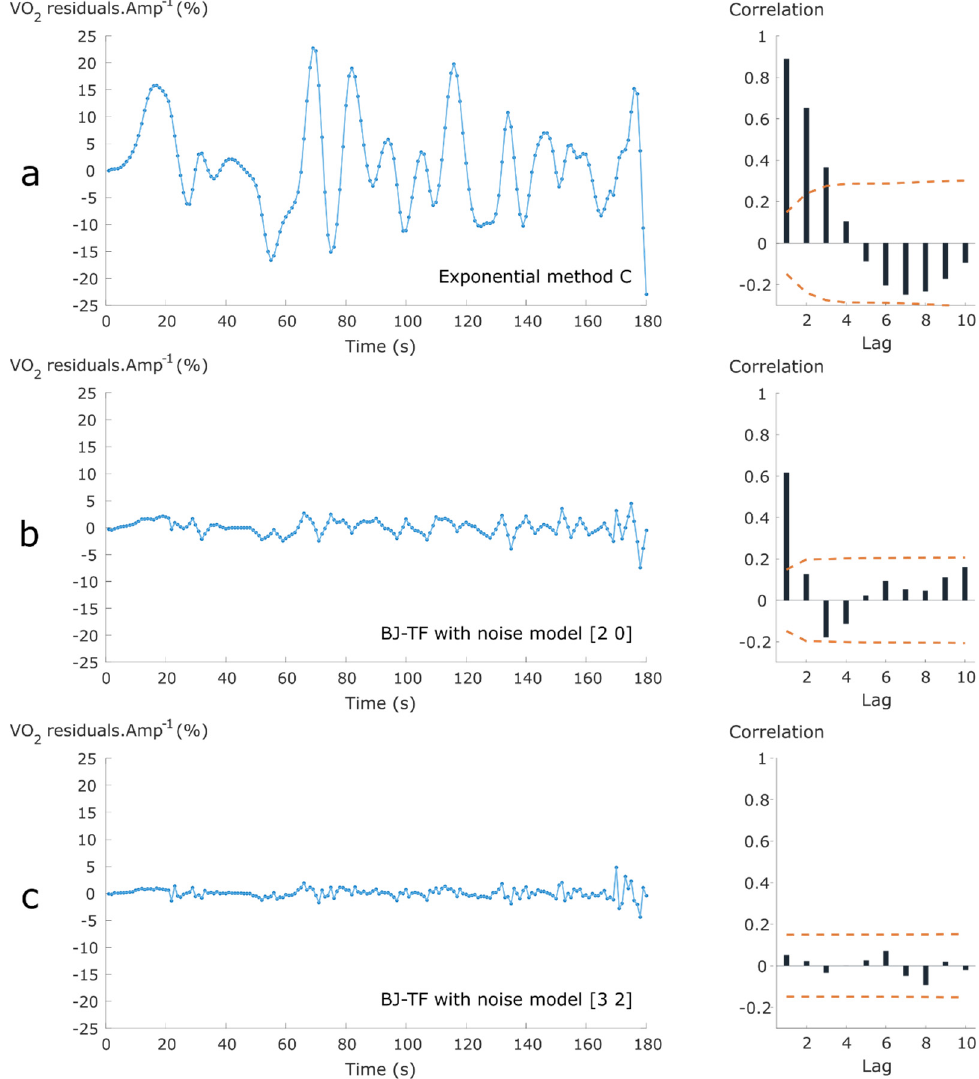
Figure 3. Residual analyses of the residuals from ( a ) exponential method C (representative for methods A and B) and Box-Jenkins transfer function (BJ-TF) models with noise model orders ( b ) [2 0] and ( c ) [3 2]. Left: residual values divided by the model parameter Amp, plotted in function of time. Right: autocorrelation coefficients up to lag 10. Table 2. Model performance characteristics for identification of the noise model order. Dark squares show noise model orders that resulted in visually inappropriate full model fits. Upper values for every noise model structure are Young Identification Criterion (YIC) values, and lower values are normalised root-mean-squared error values (NRMSE) (%).